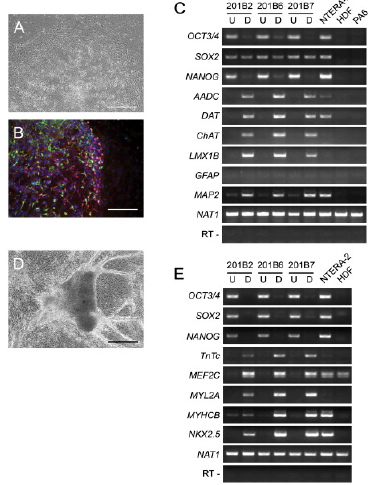
Figure 5. Directed differentiations of human induced pluripotent stem cells (iPS). ( A ) Phase-contrast image ( B ) Immunocytochemistry with β III-tubulin (red) and tyrosine hydroxylase (green) and Hoechst 33342 nuclei (blue) antibodies of differentiated iPSCs cells after 18 days culture on PA6. ( C , E ) Reverse transcriptase polymer chain reaction (RT-PCR) analyses of dopaminergic neuron and cardiomyocyte markers. ( D ) Phase-contrast image of iPS cells differentiated into cardiomyocytes. (Bars = 200 µm ( A and D ) and 100 µm ( B )). Reproduced from [82]. Copyright 2006 with permission from Elsevier.